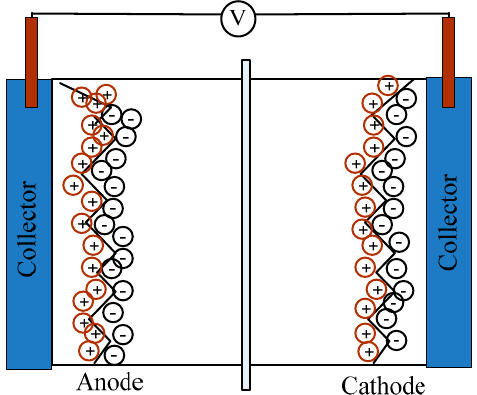
Figure 2. Electrochemical double layer capacitors (EDLC) structure.